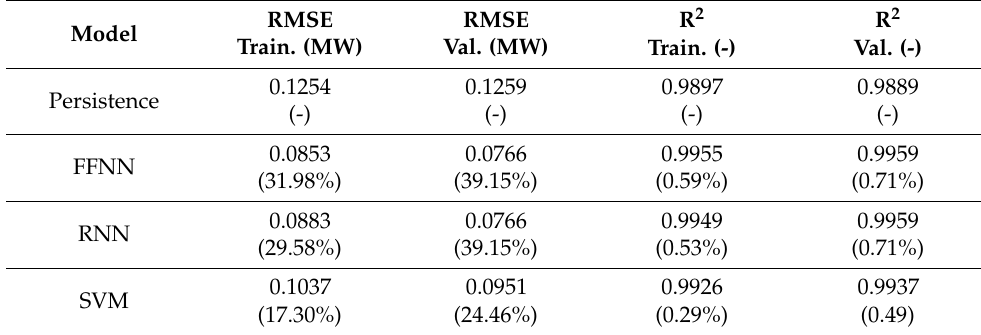
Table 8. Computed RMSE and R 2 index values for each model’s optimal